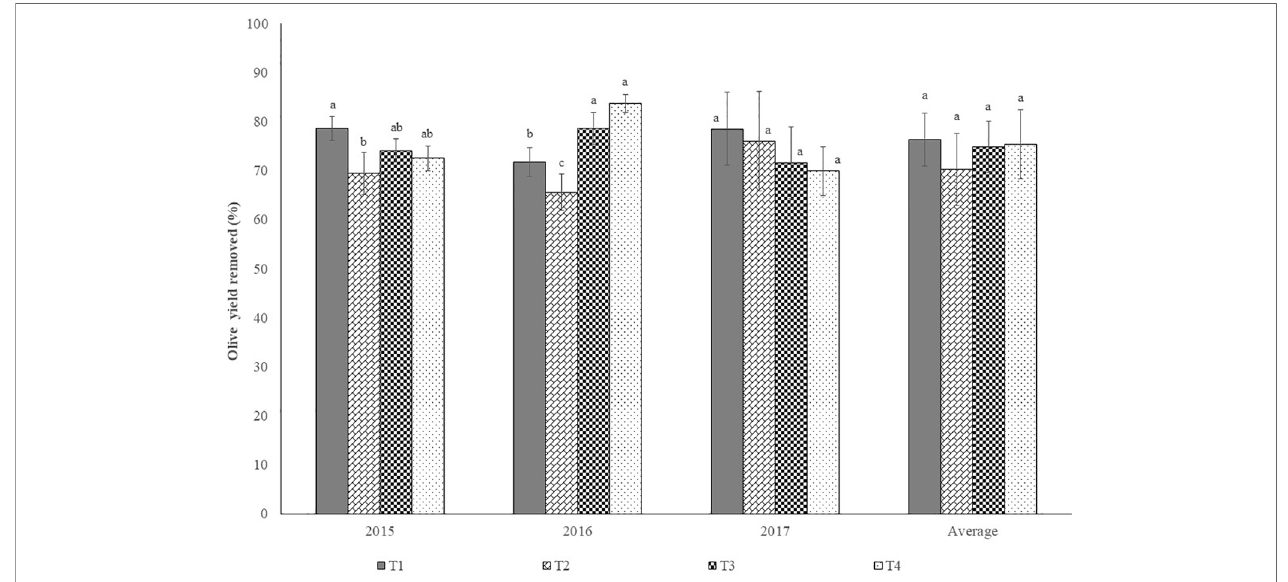
FIGURE 13 | Harvester ef fi ciency (%) by treatment, in each year and the average of the trial (mean±sd). Legend: T1, treatment 1; T2, treatment 2; T3, treatment 3; T4, treatment 4. Columns followed by the same letter are not signi fi cantly different by Duncan multiple range test at the 5%